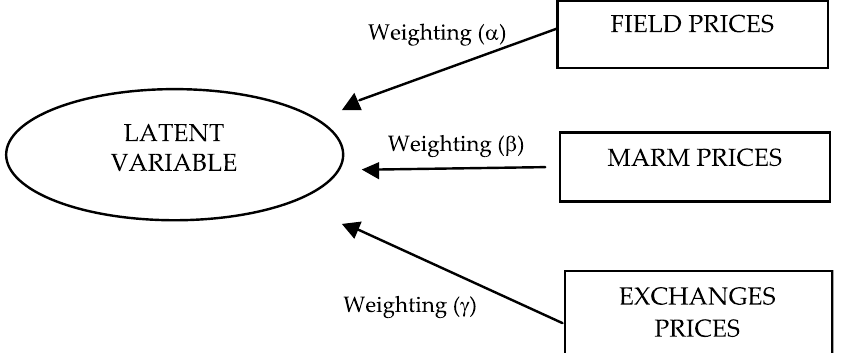
Figure 2. SEM model for determining the weighting of sources of information.